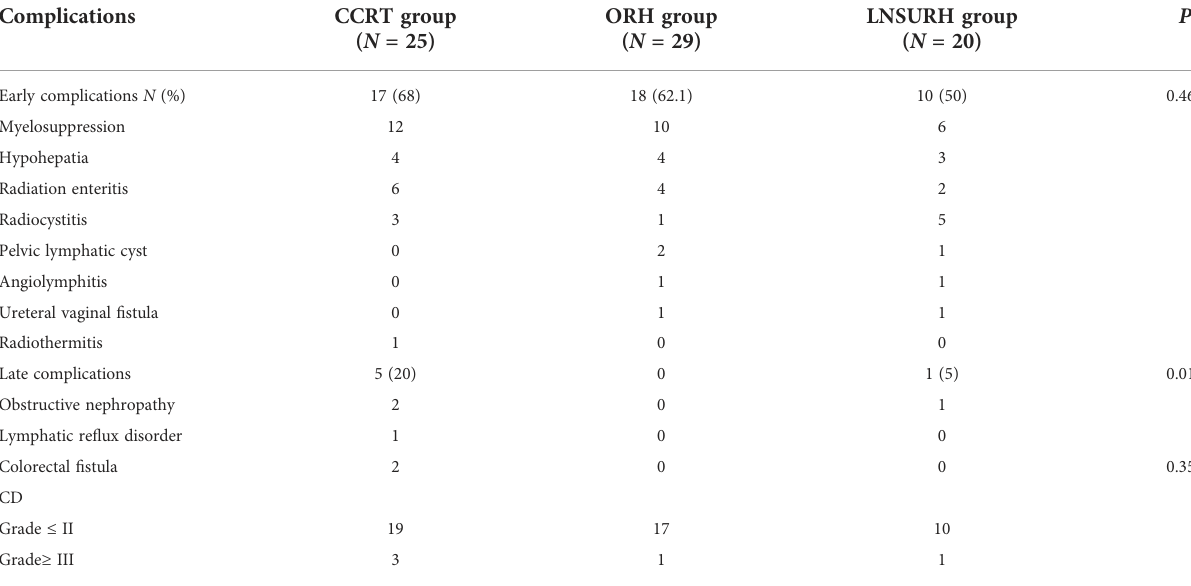
TABLE 2 Rate of complications in the CCRT, ORH, and LNSURH